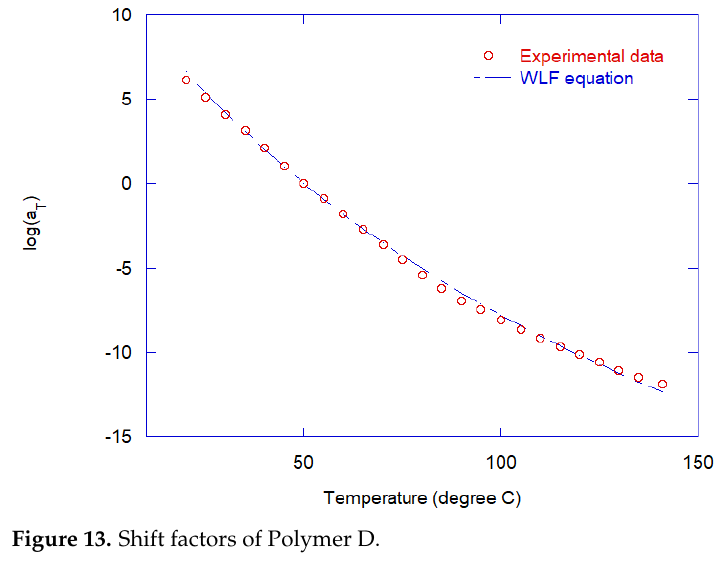
Figure 13. Shift factors of Polymer D.